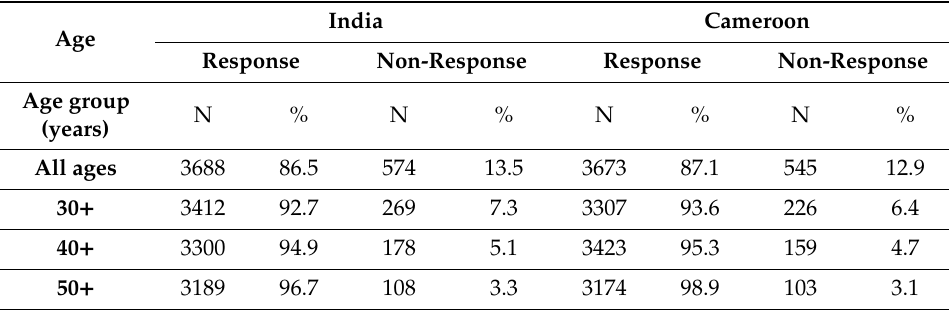
Table 3. Response and non-response by age